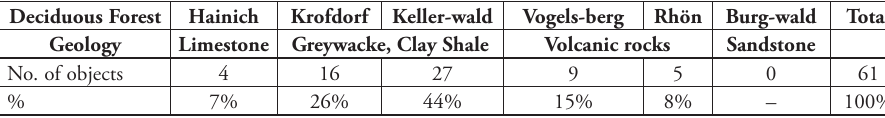
Table 2. Overview of the study sites within deciduous forest land cover. Coniferous Forest Hainich Krofdorf Keller-wald Vogels-berg Rhön Geology Limestone Greywacke, Clay Shale Volcanic rocks